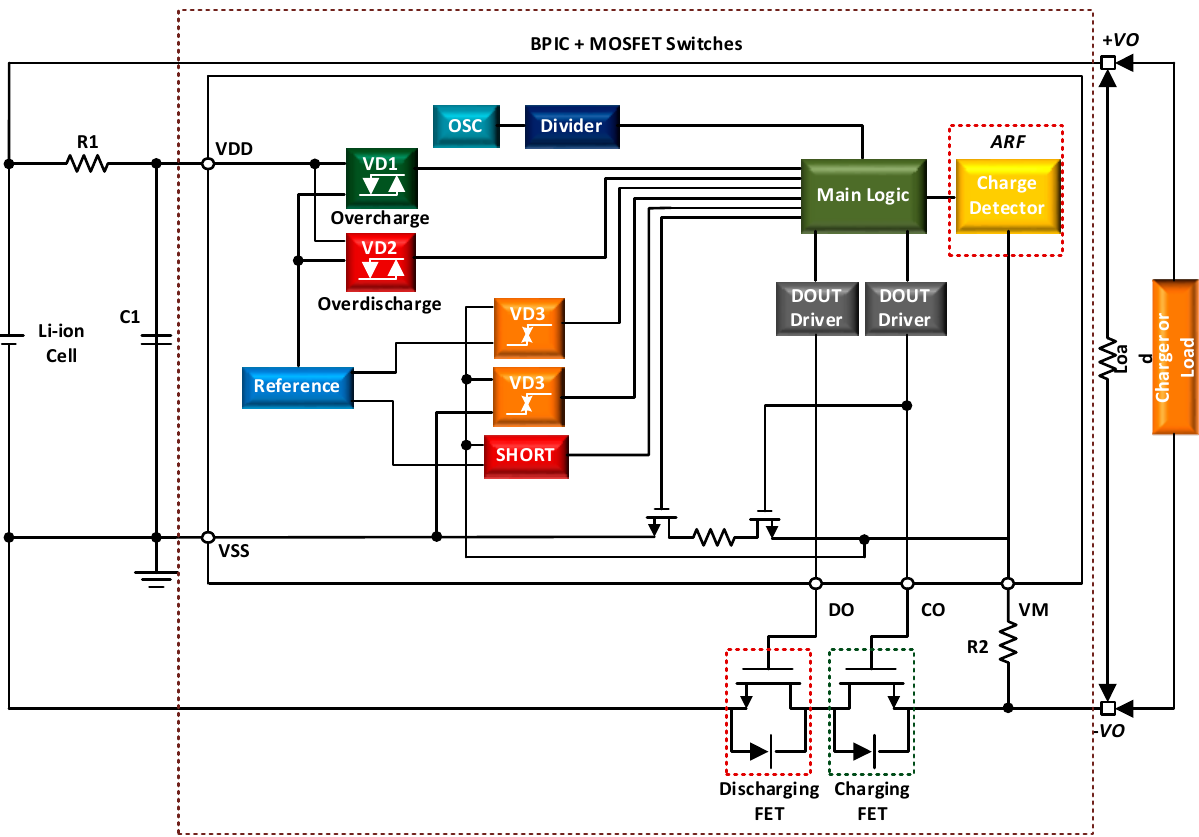
Figure 5. Block diagram of the lithium-ion battery protection circuit.